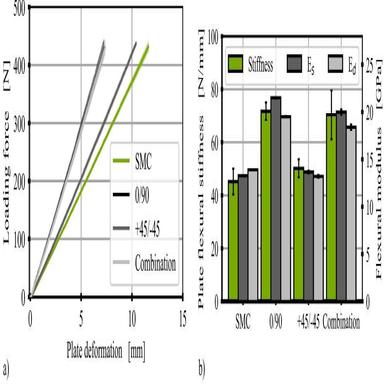
Experimentally determined force-deformation curves (a) and quantified flexural stiffness and modulus (b) by the 4-P flexural test on 2D plate level. ("Es" and "Ed" mean the determined flexural modulus using strain and displacement, respectively).